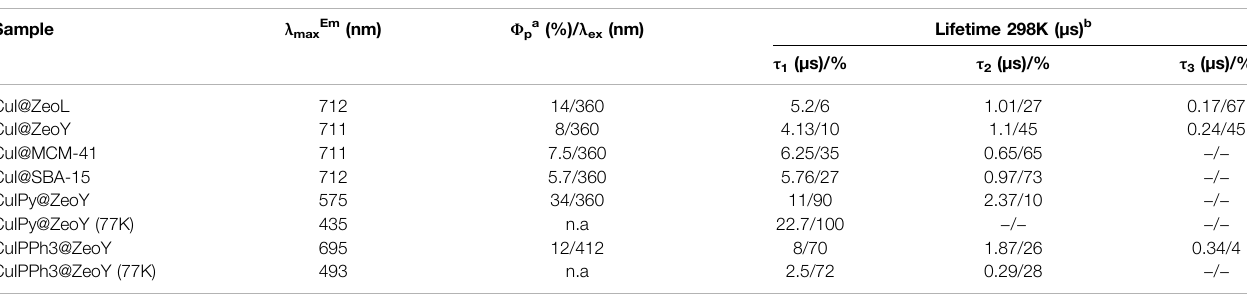
TABLE 1 | Photophysiscal properties of the different hybrid materials.